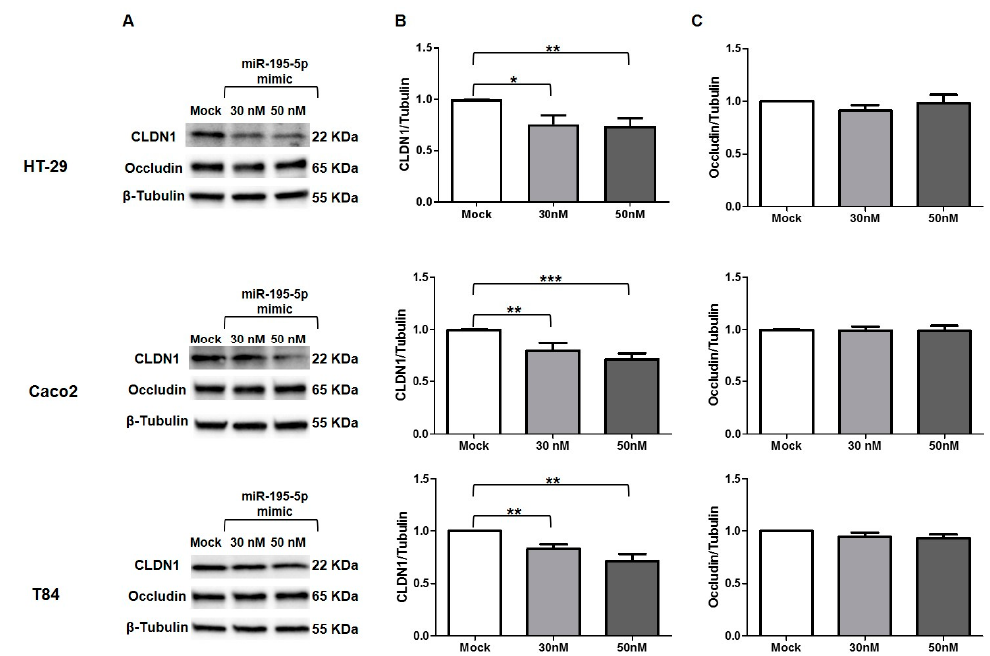
Figure 6. CLDN1 and Occludin protein expression after miR-195-5p mimic transfection. ( A ) Rep- resentative blots of CLDN1 and occludin protein expression in three IECs cell lines, HT-29, Caco2, and T84 after transfection. Western blot quantitative analysis demonstrated inhibition of CLDN1 ( B ) but not occludin ( C ) in all cell lines, after miR-195-5p mimic transfection at 30 and 50 nM. Mock represents cells which have undergone transfection without miRNA mimic. Raw data of the indepen- dent experiments of Western blot were reported in Appendix A. Data were obtained by dividing the normalized transfected sample values to normalized mock-control sample values. β -Tubulin was used as housekeeping protein to normalize the data. Data are representative of four independent experiments. The histograms correspond to mean ± SEM. * p < 0.05; ** p < 0.01, *** p <